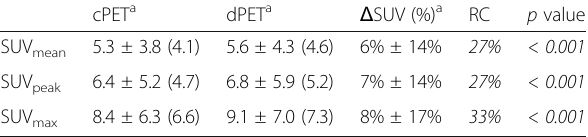
Table 2 Average SUV mean , SUV peak and SUV max across all lesions ( n = 128), the relative difference Δ SUV between both systems and the RC per SUV-parameter. dPET SUVs were higher than cPETSUVs ( p < 0.001) with average Δ SUVs of 6 – 8%